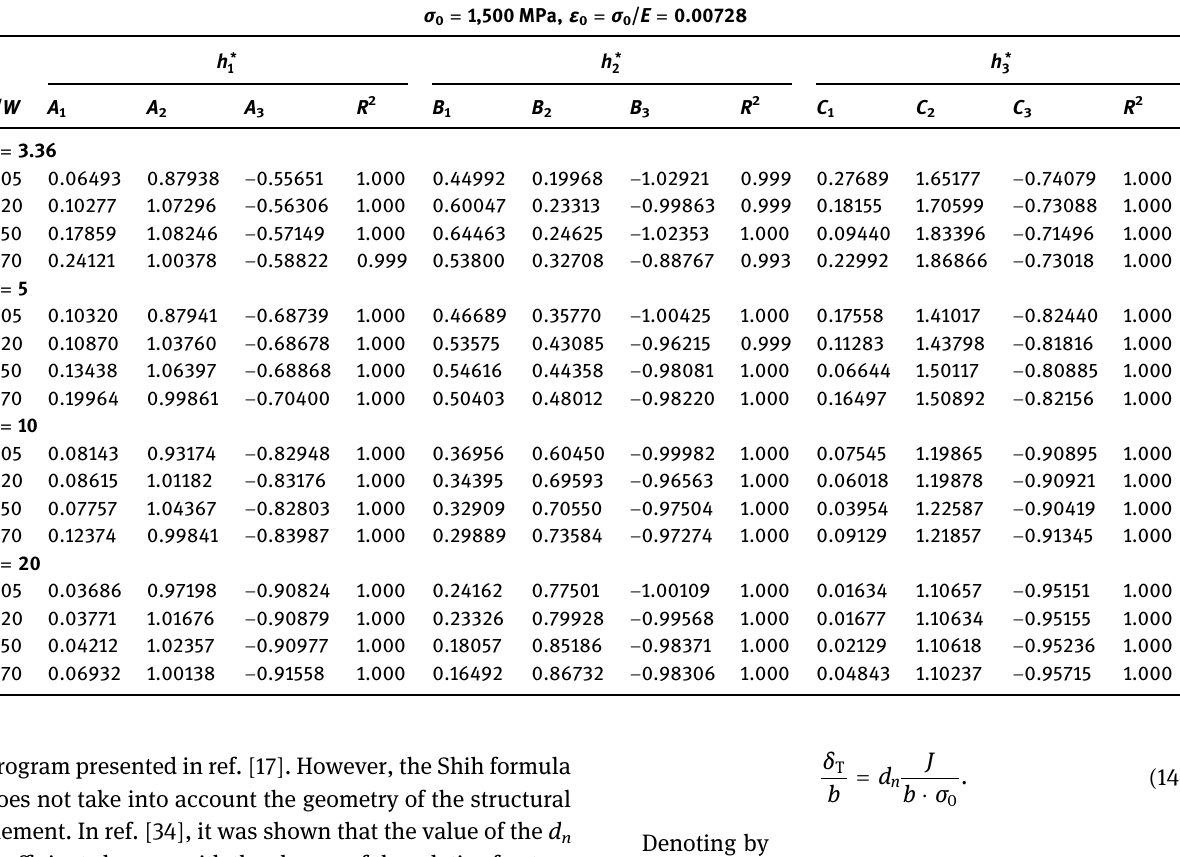
Table 5: Coe ffi cients of matching equations ( 11 – 13 ) to the obtained numerical results for materials described with the yield point σ = 1,500 0